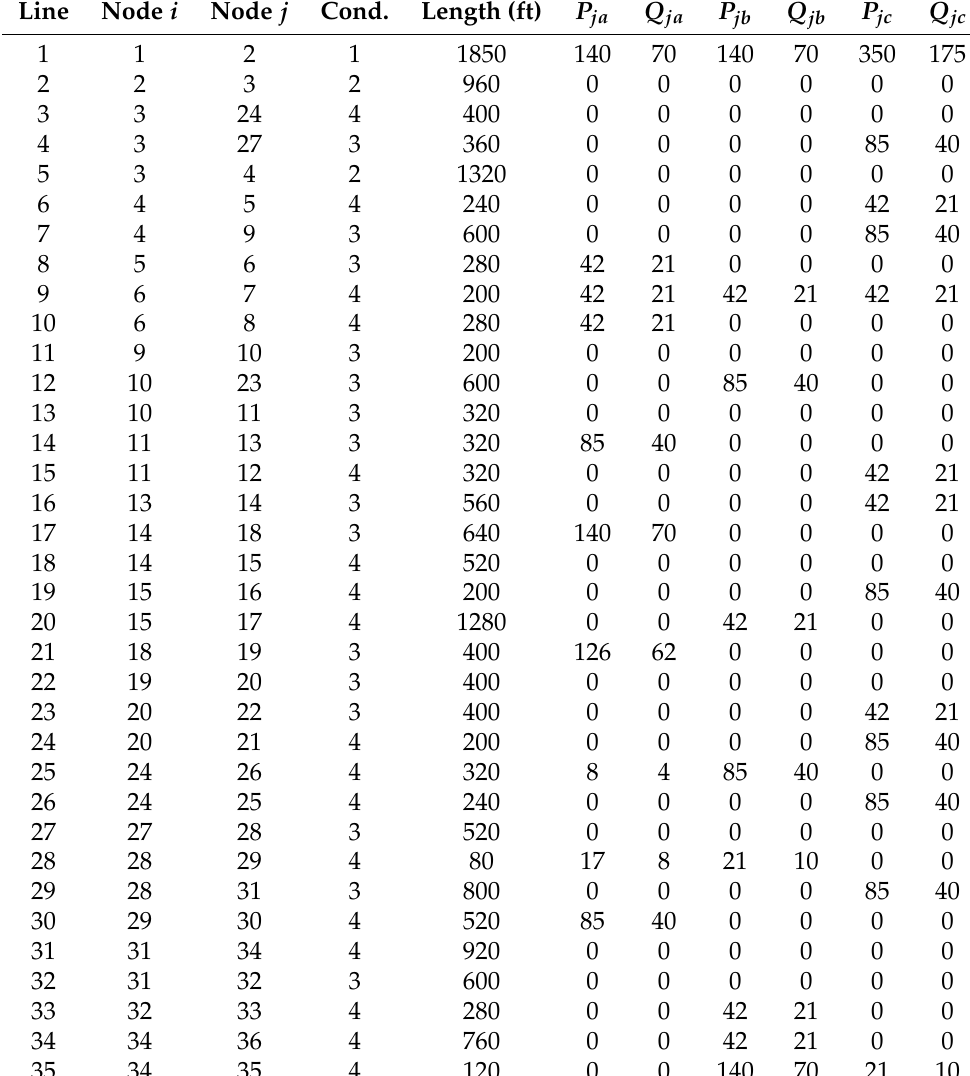
Table 4. Line and load parameters of the IEEE 37-bus system (all power values are in kW and kvar).